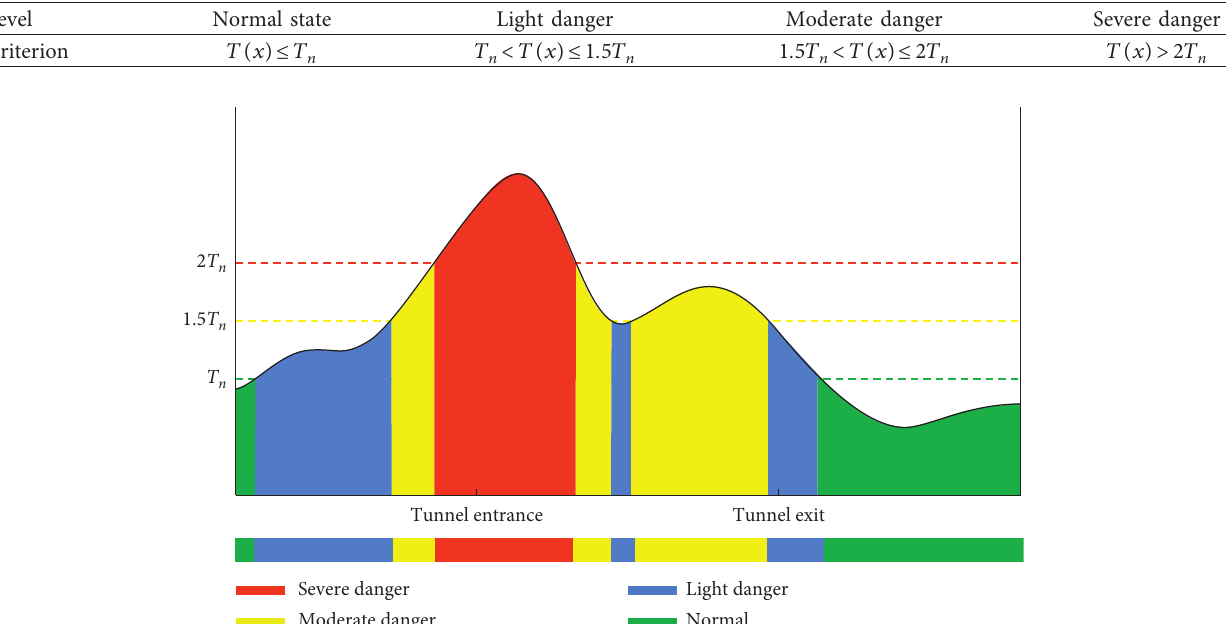
Table 7: Classification criteria of tunnel environmental risk level.